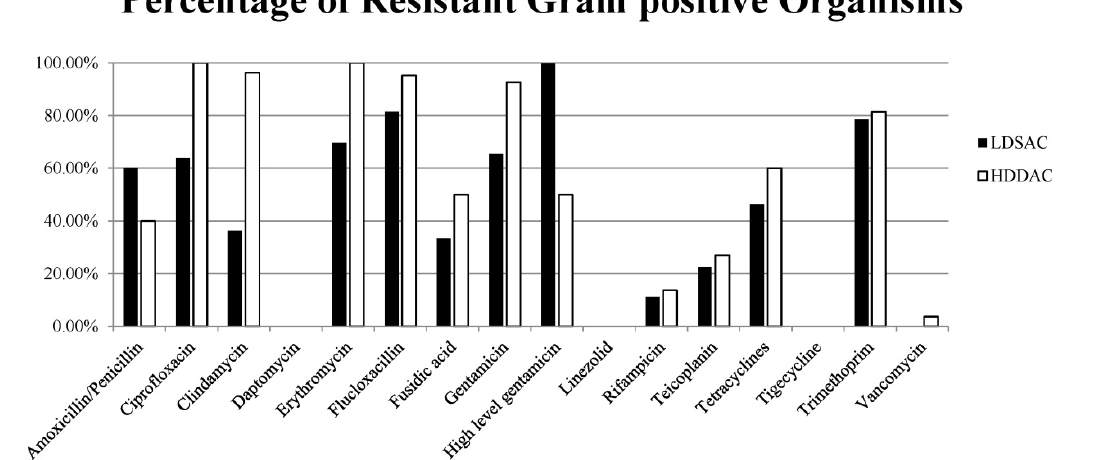
Figure 2. Resistance in Gram positive organisms